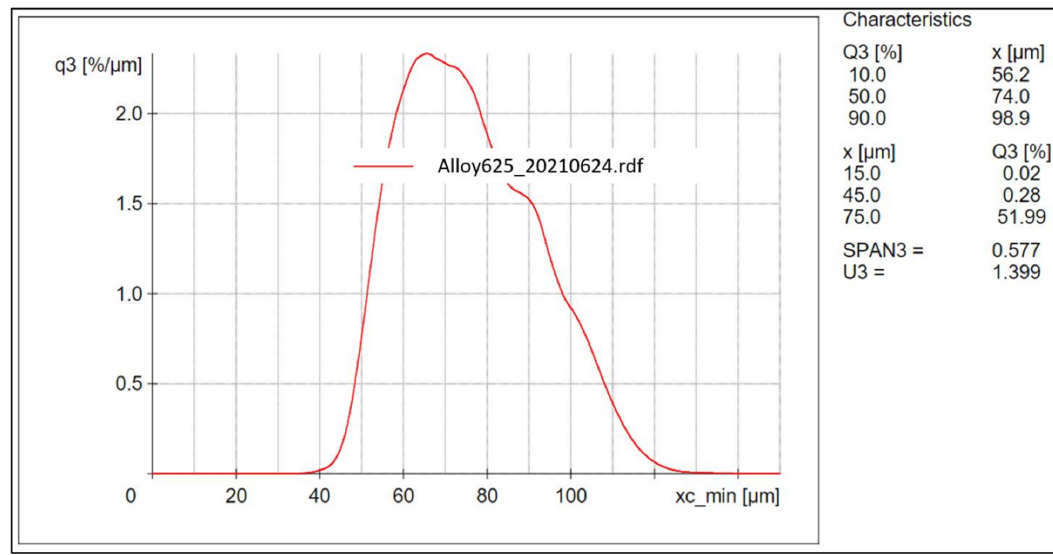
Figure 1. Particle size distribution graph.